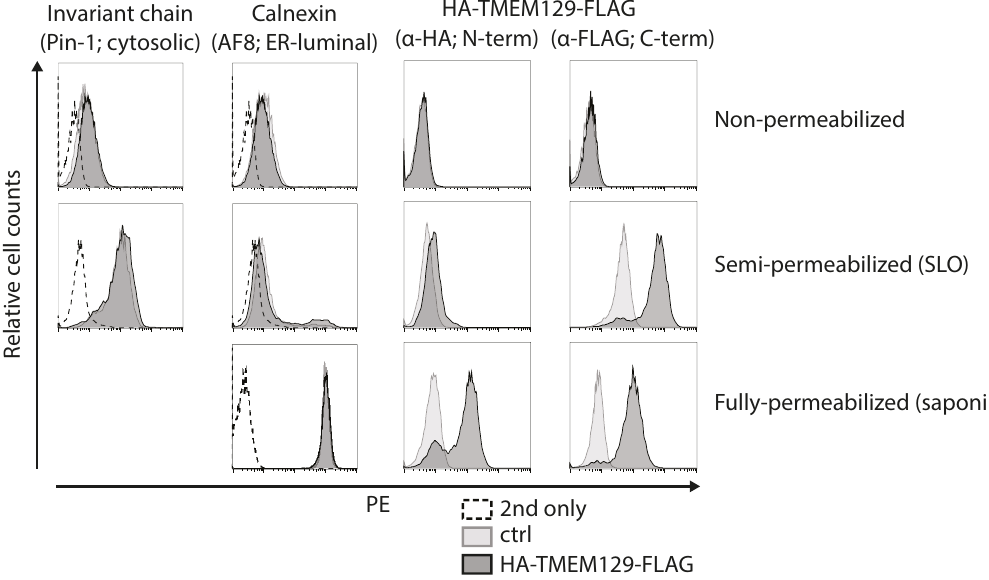
Figure 2. The N-terminus of TMEM129 is localized in the ER lumen, the C-terminus in the cytosol. U937 cells transduced with either HA-TMEM129-FLAG or vector control (ctrl) were either left untreated (non-permeabilized), semi-permeabilized using streptolysin-O (SLO), or fully-permeabilized using saponin. The termini of HA-TMEM129-FLAG were detected using HA- or FLAG-reactive antibodies respectively, after which flow cytometric analysis was performed. As a control for semi-permeabilization, cells were stained with a monoclonal antibody directed against a cytosolic epitope of the invariant chain (Ii) or were incubated with the secondary antibody only (2nd only). As a control for full-permeabilization, cells were stained with a monoclonal antibody directed against an ER-luminal epitope of calnexin or they were incubated with the secondary antibody only. Experiments were performed three times, of which one representative experiment is shown.